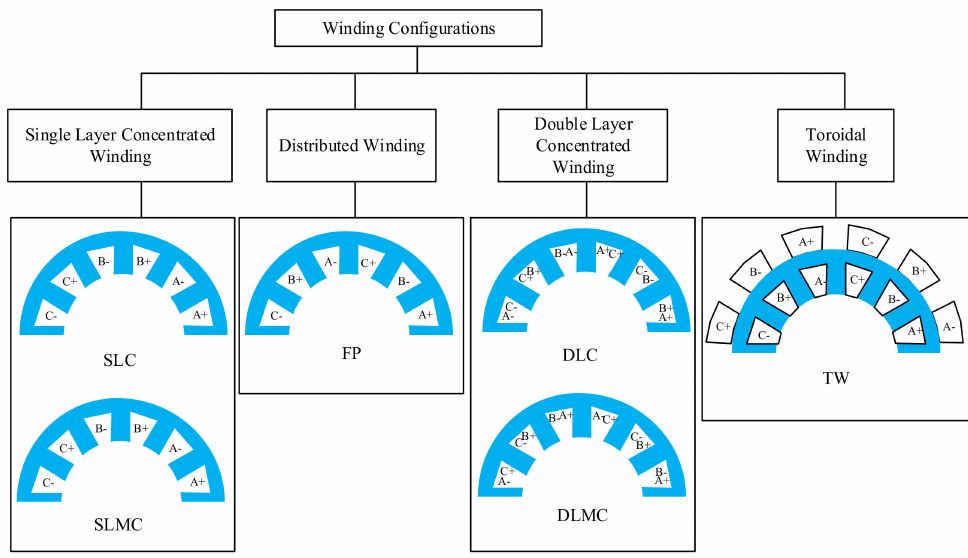
Figure 2. Different winding configurations for switched reluctance motors edited from